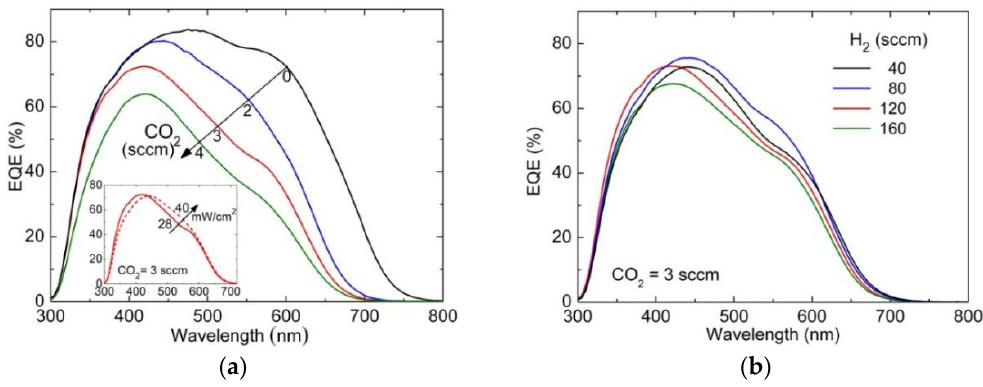
Figure 2. External quantum efficiency (EQE) of a-SiO x :H solar cells: ( a ) series deposited with different CO 2 values, setting H 2 =120 sccm; ( b ) series deposited with different H 2 flow rates, setting CO 2 = 3 sccm. In ( a ) the black curve corresponds to the reference cell that uses our standard a-Si:H, with no H 2 dilution, as absorber layer; the inset shows the effect of increased discharge power density for CO 2 = 3 sccm.